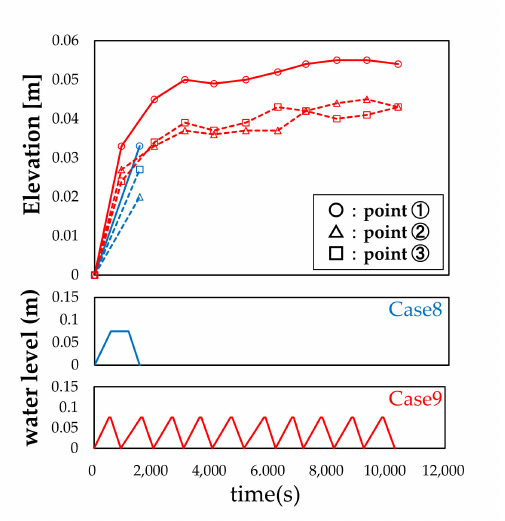
Figure 10. Local scour depth of Cases 8 and 9.